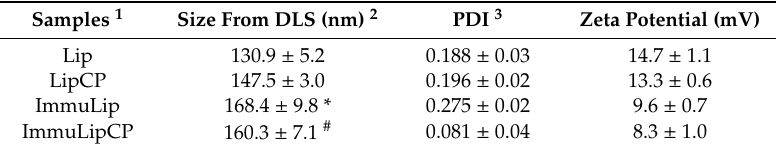
Table 1. Size and zeta potentials values ( n = 3, mean ± SD).